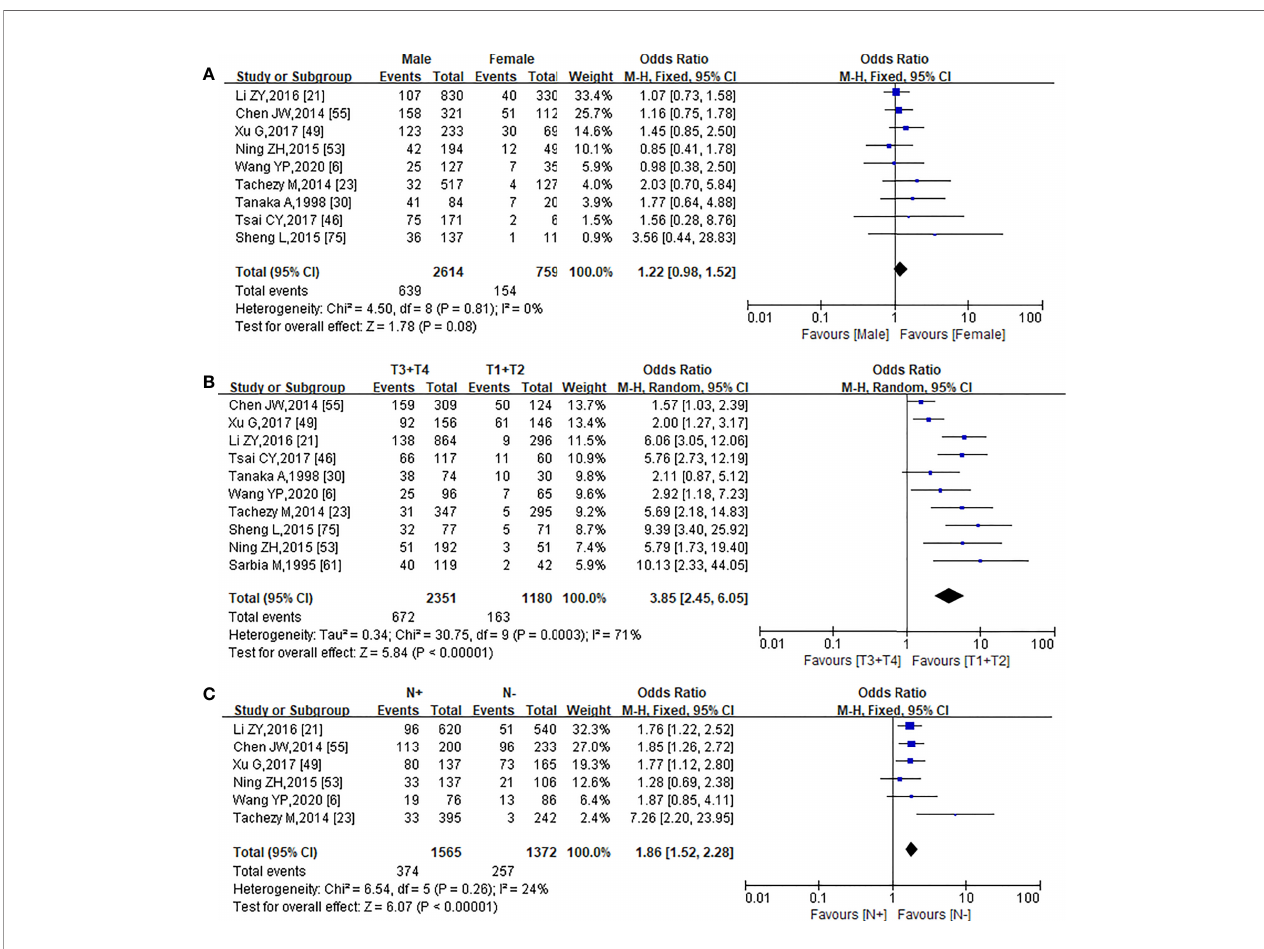
FIGURE 2 | Forest plot of the pooled OR for the association of PNI with Gender (A) , pTstage (B) , and pN stage (C) .